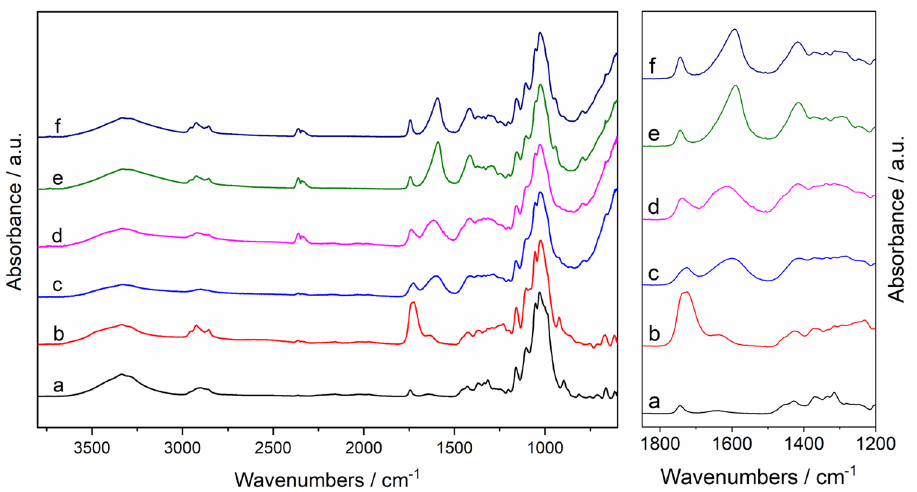
Figure 1. ATR-FTIR spectra of the dried TOCNF suspension and TOCNF–M n+ hydrogels: (a) pristine CNF (b) TOCNF, (c) TOCNF–Fe 3+ , (d) TOCNF–Al 3+ , (e) TOCNF–Ca 2+ , (f) TOCNF–Mg 2+ . Left: full spectra, right: region of